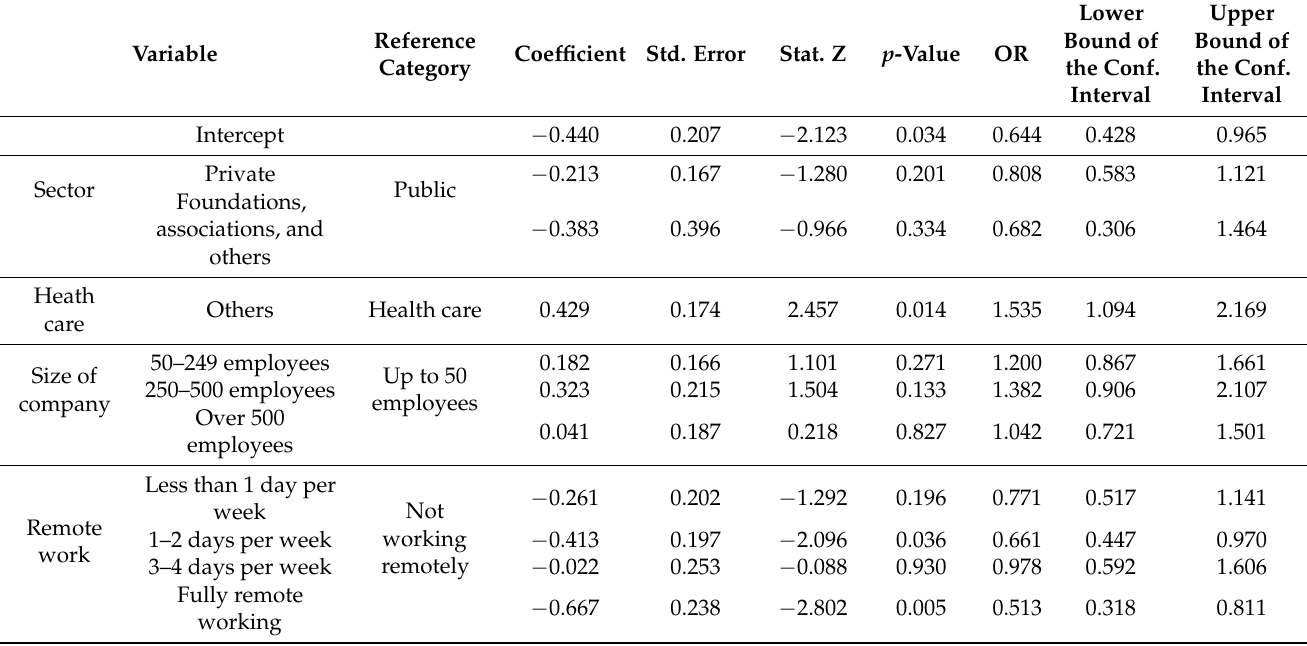
Table 4. A logistic model explaining the chance of well-being—“workplace relationships”